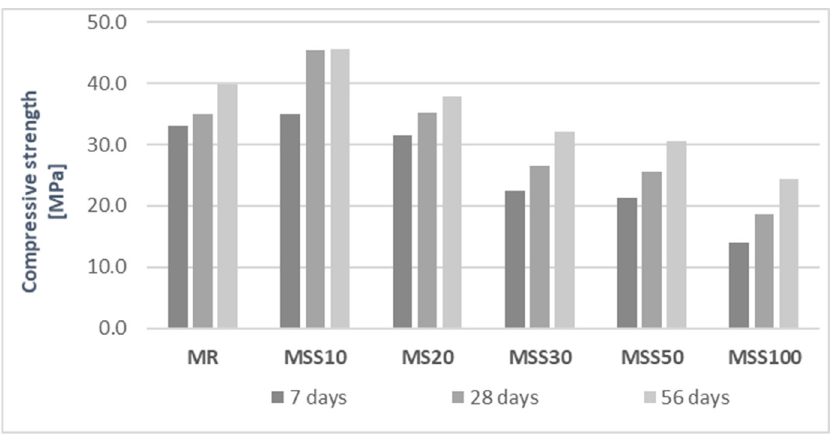
Figure 12. Compressive strength of mortars after 7, 28, and 56 days of maturation.